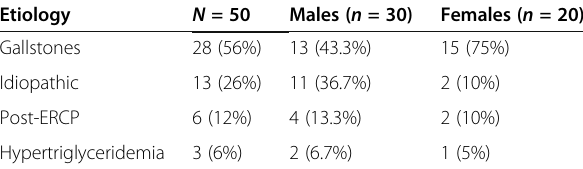
Table 2 Etiology of acute pancreatitis in studied patients